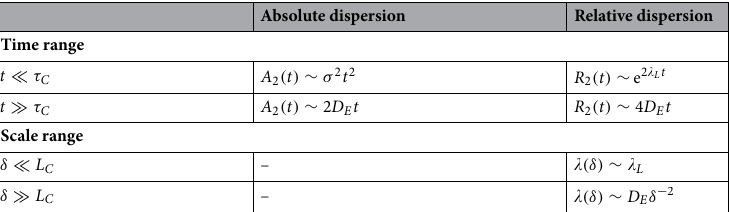
t ) and R t ) are the second order moments 2 ( 2 (